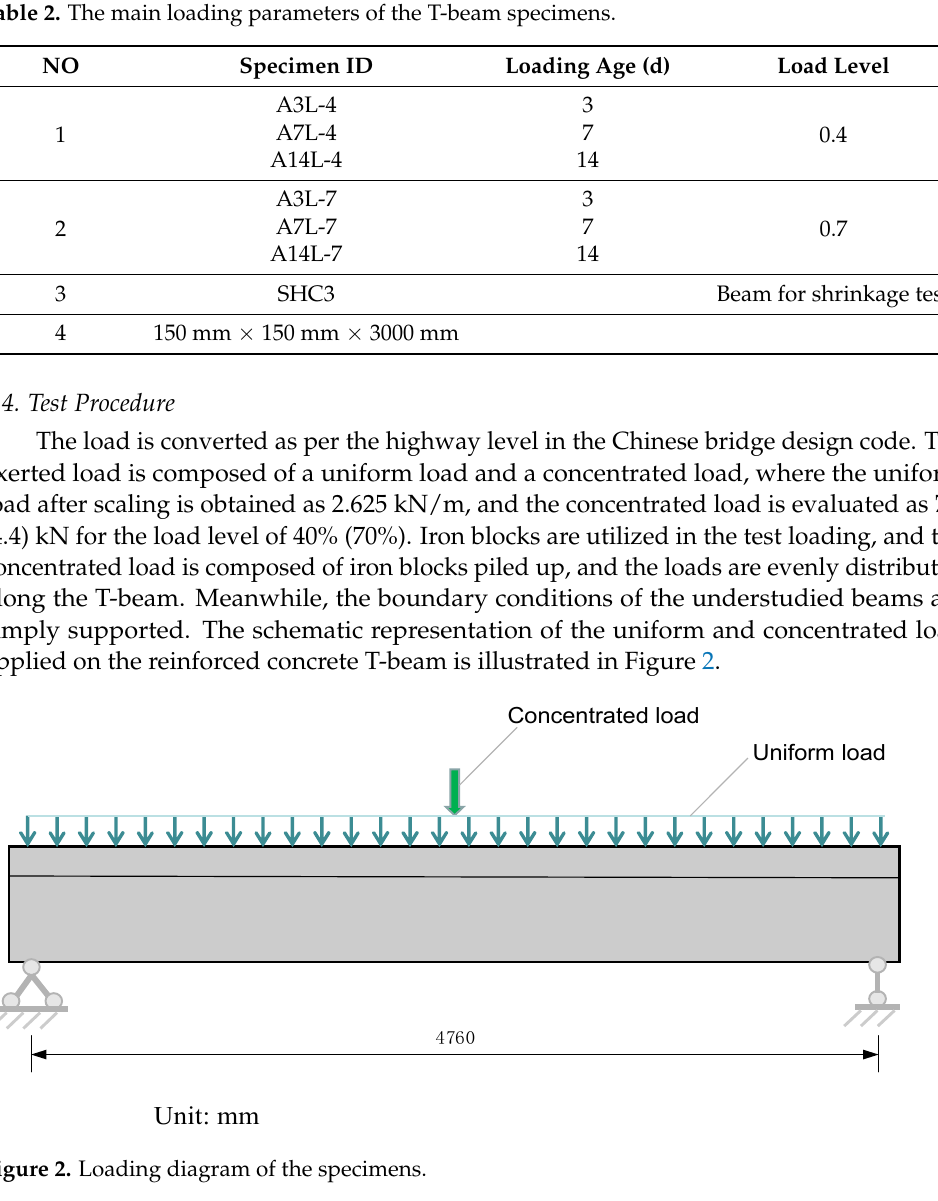
Table 2. The main loading parameters of the T ‐ beam specimens.